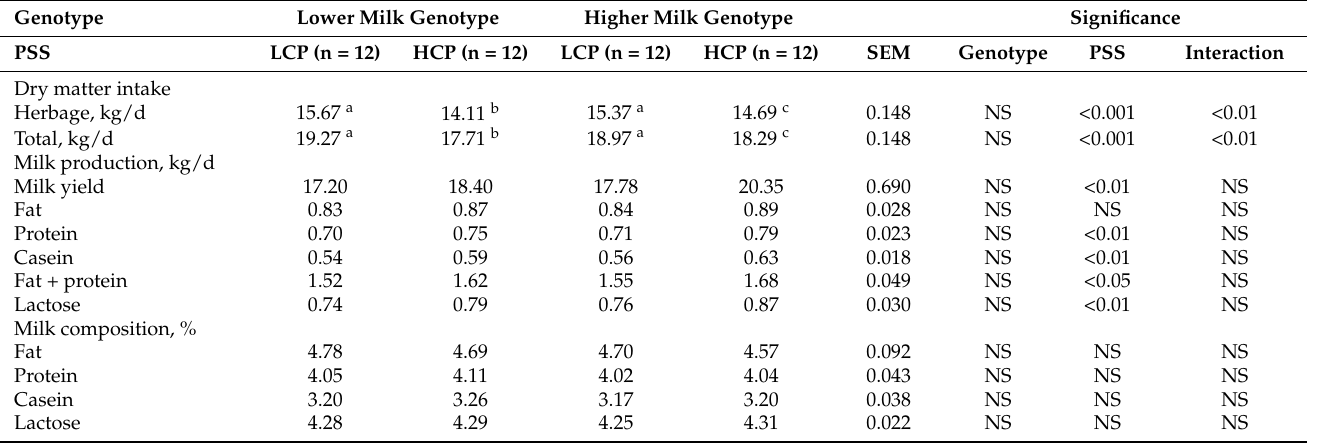
Table 3. Effects of protein supplementation strategy (PSS) genotype on dry matter intake, milk production and milk composition 1